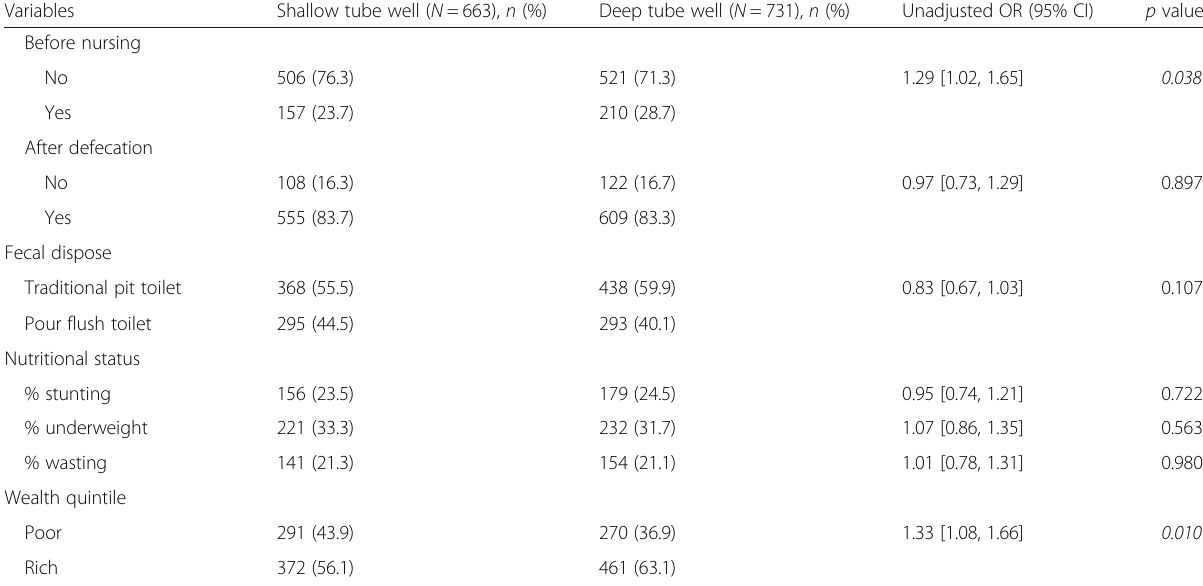
Table 2 Characteristics of under-5 moderate-to-severe diarrheal children from the two types of tube well water-user families (Continued) Variables Shallow tube well ( N = 663), n